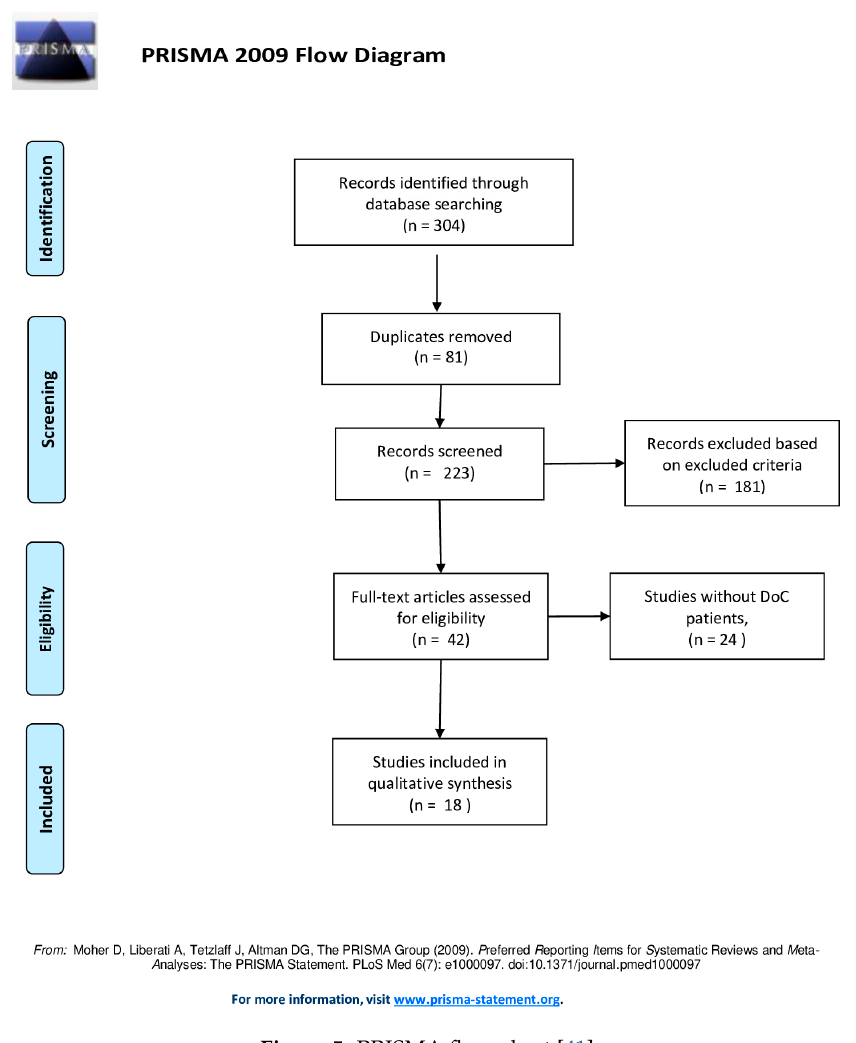
Figure 5. PRISMA flow-chart. [41]